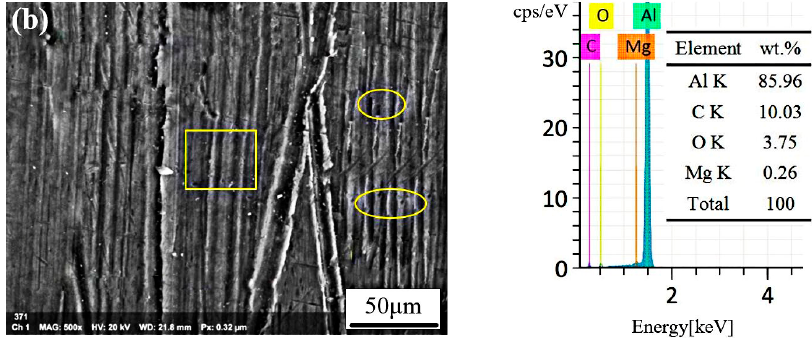
Figure 9. SEM micrographs and EDS spectrums of samples ( a ) incompletely cleaned sample and ( b ) completely cleaned sample.